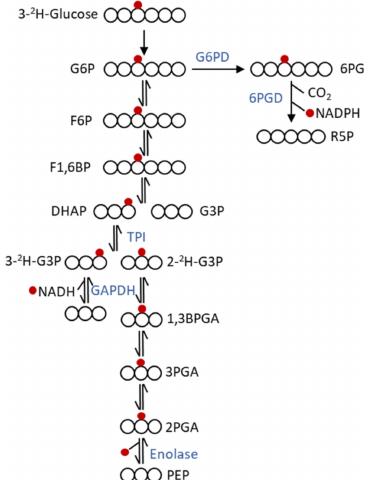
Figure 3. Fate of 2 H at position 3 of glucose. 3- 2 H-glucose can produce deuterium labeled NADPH when processed through oxPPP and NADH and water when processed through glycolysis. The deuterium-labeled hydrogen is marked with a red dot. Abbreviation: G6P: glucose-6-phosphate;